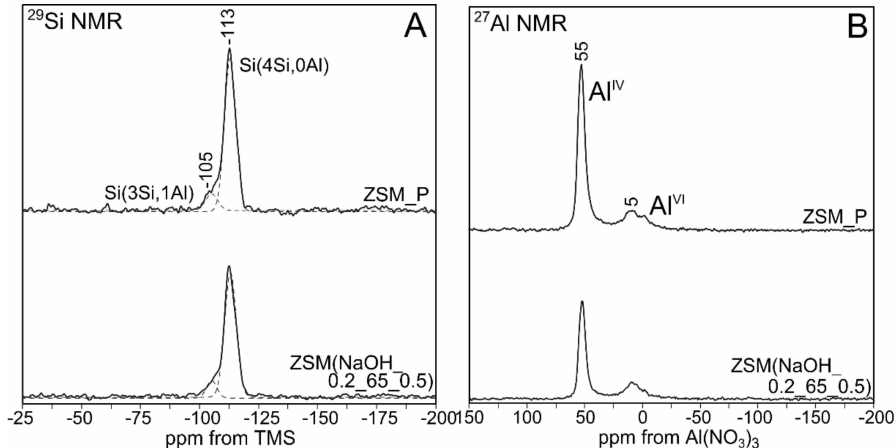
Figure 4. ( A ) 29 Si MAS NMR and ( B ) 27 Al MAS NMR spectra of ZSM_P and its modified